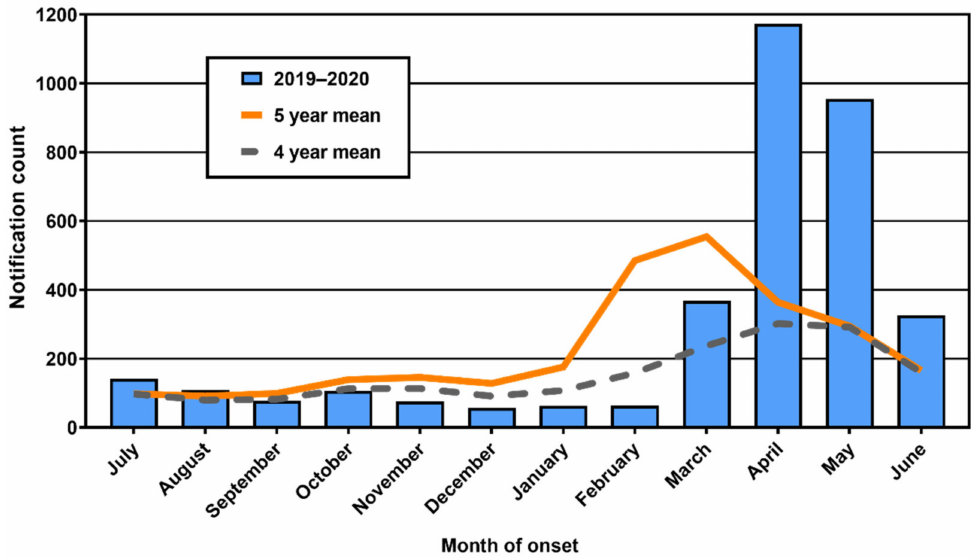
Figure 1. Ross River virus infection notifications in Queensland by month for the 2019–2020 reporting year. Monthly means for the previous 4 and 5 reporting years are provided for comparison. Note that 5-year mean includes notifications comprising a large outbreak in 2014–2015.